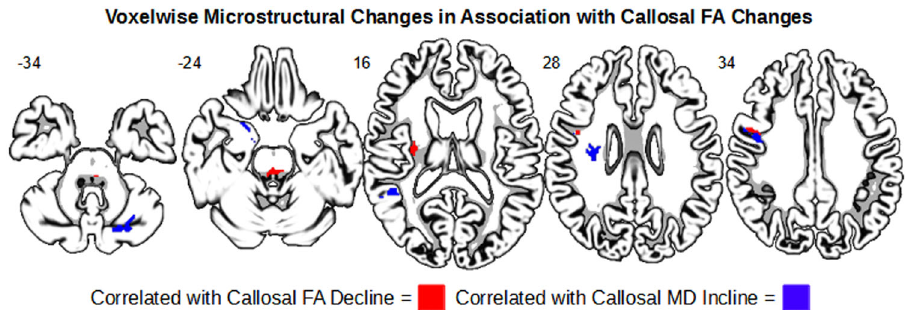
Fig. 5 Whole-brain regression maps showing changes in callosal FA in association with widespread microstructure decline. Red indicates areas where callosal FA decline was associated with FA decrease. Blue indicates areas where callosal FA decline was associated with MD